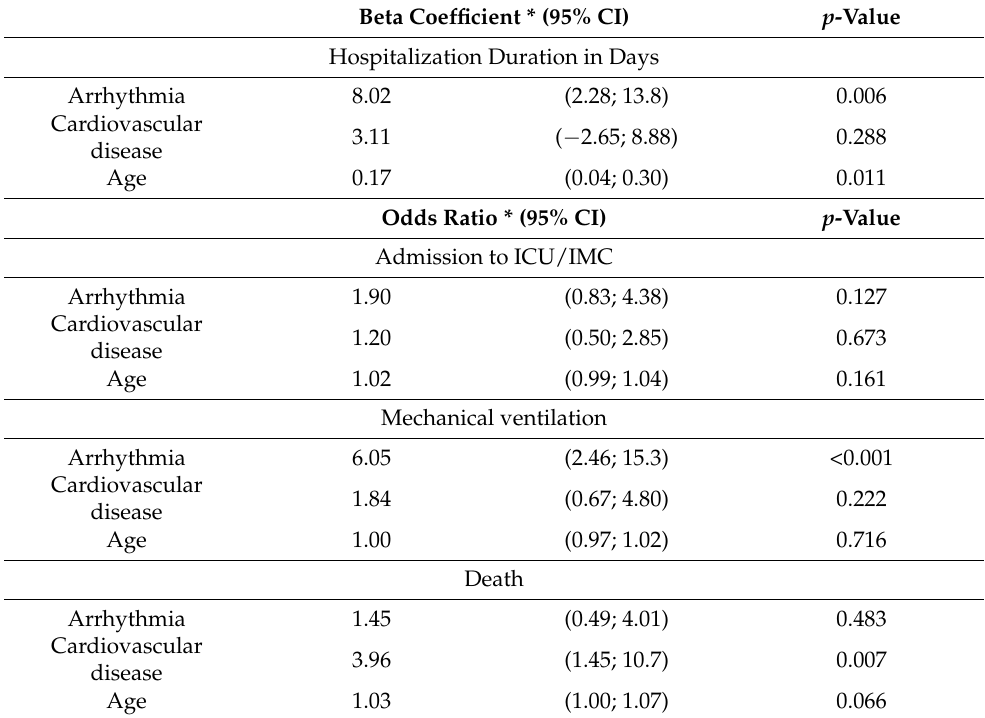
Table 4. Multiple regression models of clinical outcome parameters associated with